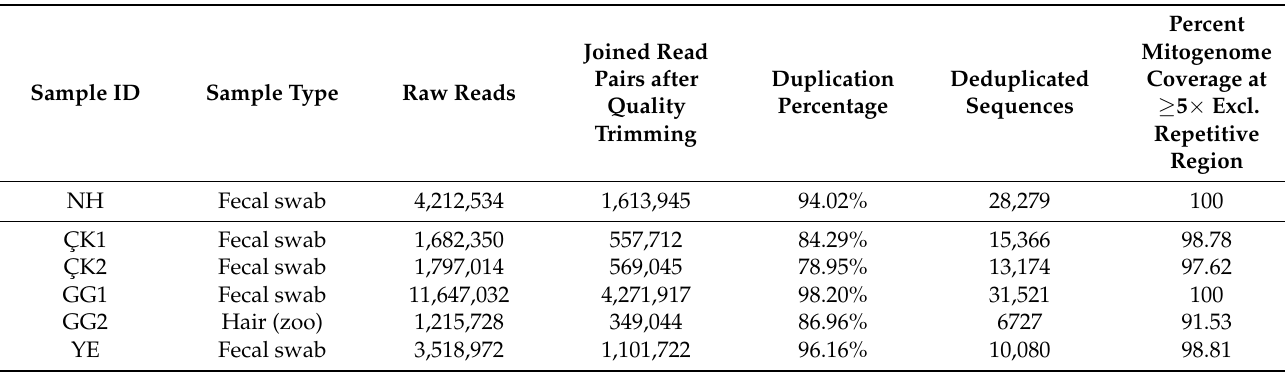
Table 2. Summary of sequencing results following targeted capture for the six Anatolian samples with complete or near-complete